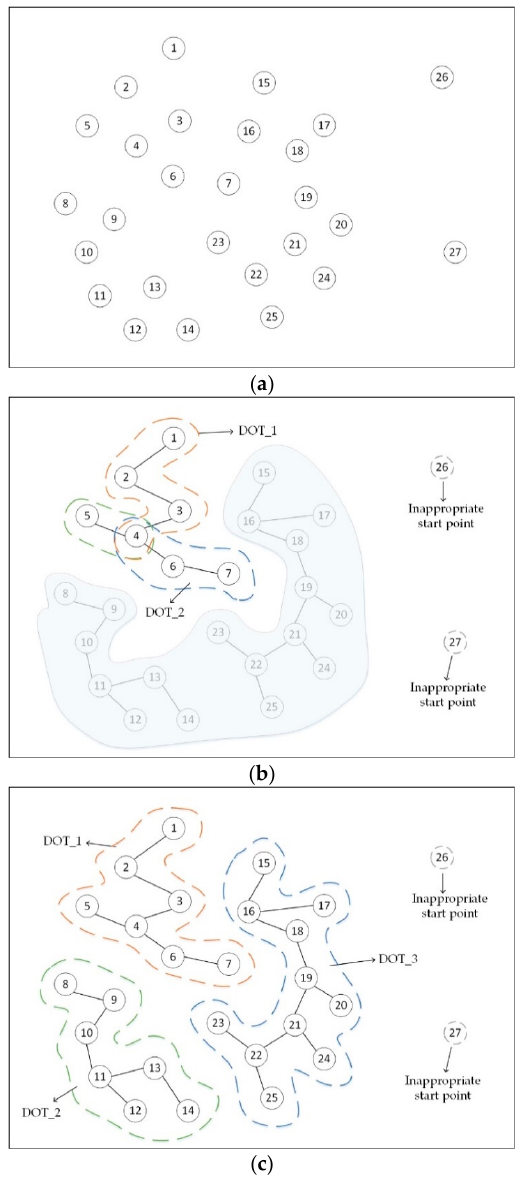
Figure 3. Illustration of the stage of constructing Multiple Density-Ordered Trees (MDOT): ( a ) Original dataset; ( b ) Example of the growth of MDOT; and ( c ) Result of constructing MDOT.